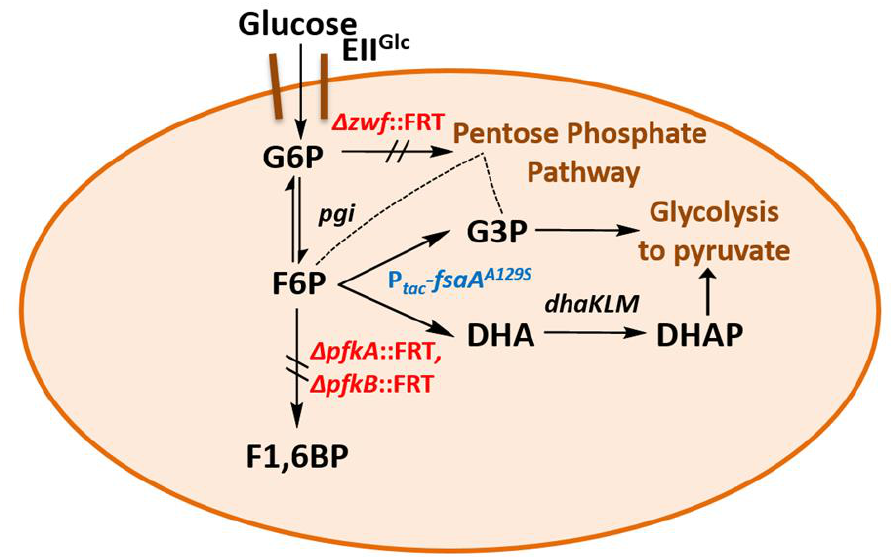
Figure 4. Schematic of a glucose bypass metabolism in the strains GL3/pJF fsaA A129S and GL4. DHA, dihydroxyacetone; dhaKLM , genes for dihydroxyacetone kinase; DHAP, dihydroxyacetone phosphate; EII Glc , glucose transporter; F1,6BP, fructose 1,6-bisphosphate; F6P, fructose 6-phosphate; FRT, FLP recognition target; fsaA , fructose 6-phosphate aldolase gene; G3P, glyceraldehyde 3-phosphate; G6P, glucose 6-phosphate; pfkA, pfkB , phosphofructokinase genes; pgi , phosphoglucose isomerase gene; P tac , tac promoter; zwf , glucose 6-phosphate dehydrogenase gene.